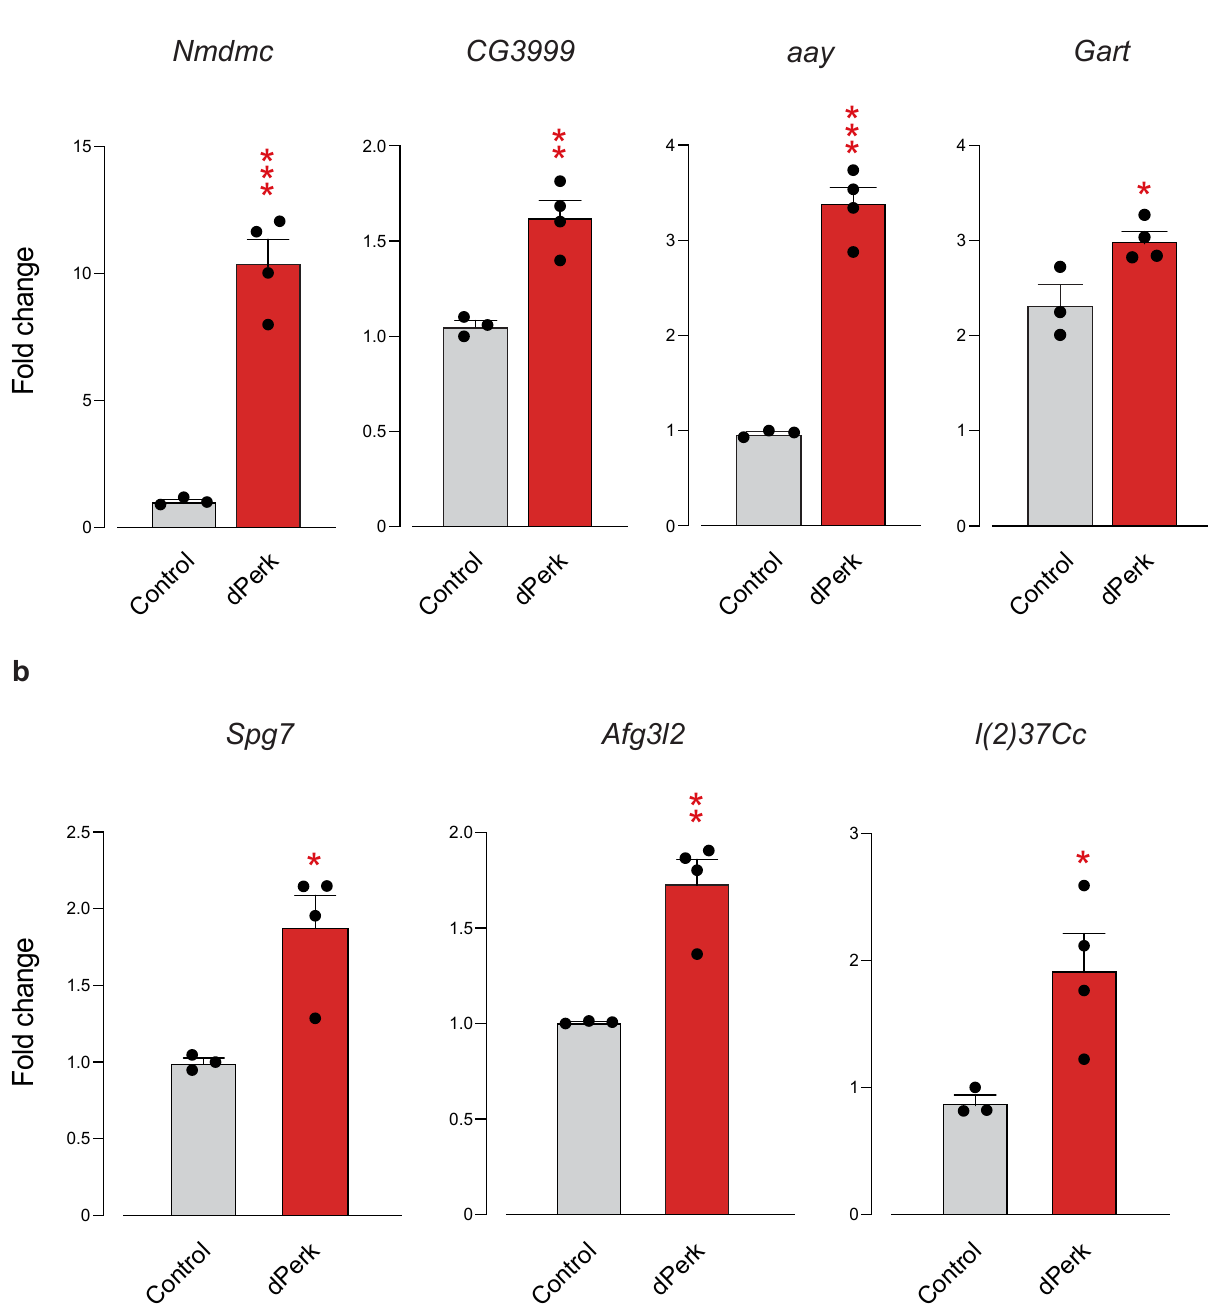
Figure 9. dPerk overexpression causes an upregulation in mRNA levels of molecules regulating nucleotide metabolism and mitochondrial calcium signalling. ( a ) dPerk overexpression results in transcriptional upregulation of nucleotide metabolism genes NAD-dependent methylenetetrahydrofolate dehydrogenase ( Nmdmc ), CG3999 , a glycine dehydrogenase (GLDC) orthologue, astray (aay ) and GART trifunctional enzyme ( Gart ). ( b ) dPerk overexpression results in transcriptional upregulation of the Paraplegin ( Spg7 ), AFG3 like matrix AAA peptidase subunit 2 ( Afg3l2 ) and lethal (2) 37Cc ( l(2)37Cc ) genes involved in essential mitochondrial calcium uniporter regulator (EMRE) processing. Expression levels were measured by real-time qPCR. All bar plots show the mean ± SEM; asterisks, unpaired t -test. Genotypes, Control: tub Gal80; da Gal4 > +, dPerk: tub Gal80; da Gal4 > dPerk -HA. Adult flies were heat-shock for 15 h at 29 ◦